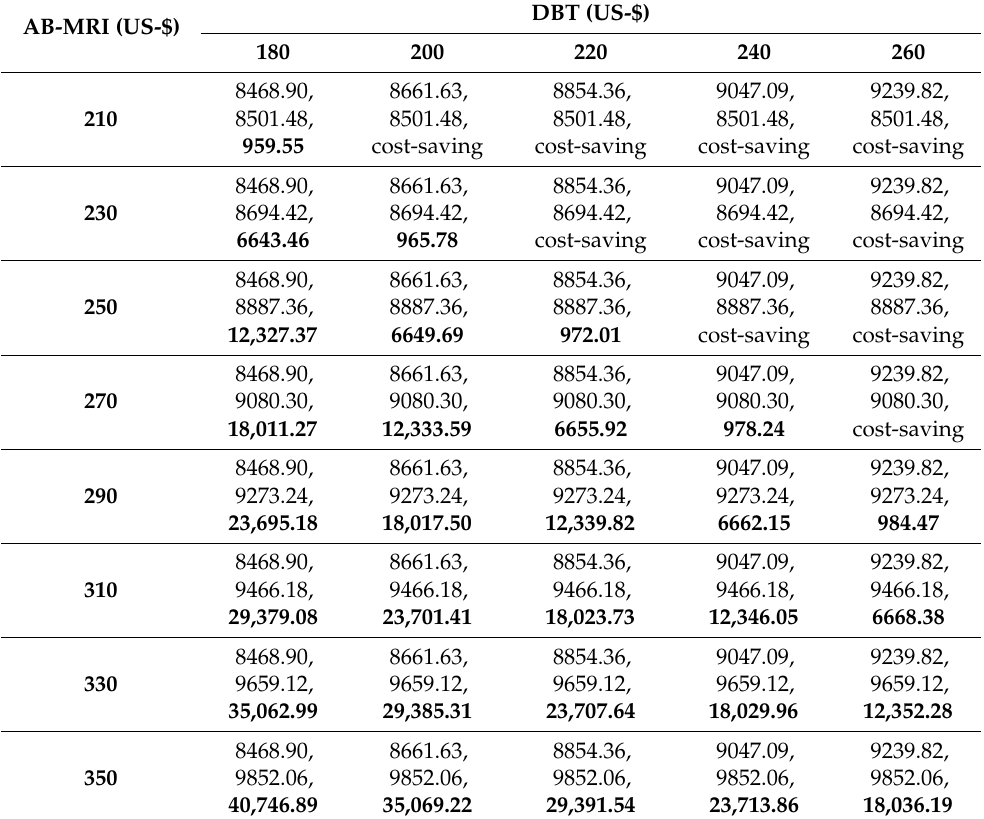
Table 3. Discounted cumulative costs of screening with DBT and AB-MRI (US-$) and the resulting cost-effectiveness expressed by the incremental cost-effectiveness ratio (ICER in US-$ per QALY gained) for varying costs of the diagnostic procedures. AB-MRI, abbreviated breast MRI; DBT, digital breast tomosynthesis.